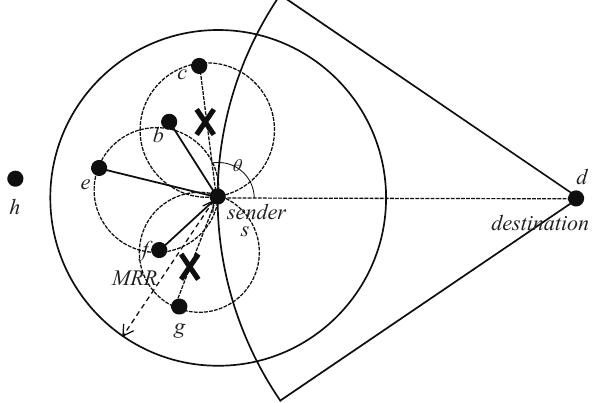
Figure 6. An example of the beaconless recovery forwarding